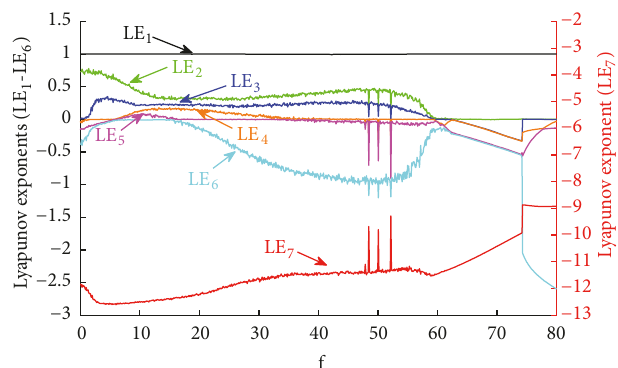
Figure 2: Lyapunov exponent spectrum of the 7D Lorenz hyperchaotic system